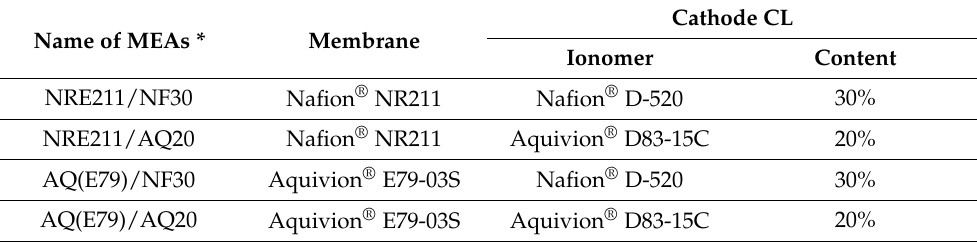
Table 1. List of the investigated